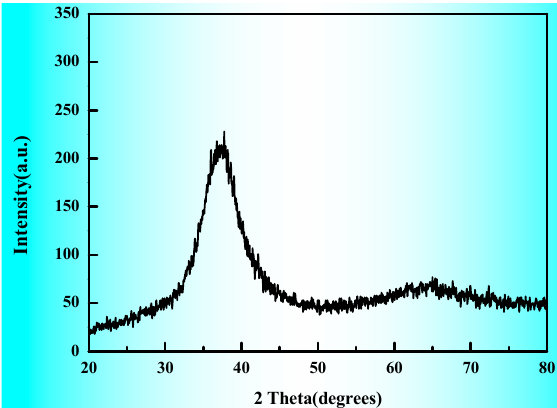
Figure 3. X-ray diffraction pattern of the Zr 58 Cu 15.46 Ni 12.74 Al 10.34 Nb 2.76 Y 0.5 BMG specimen.